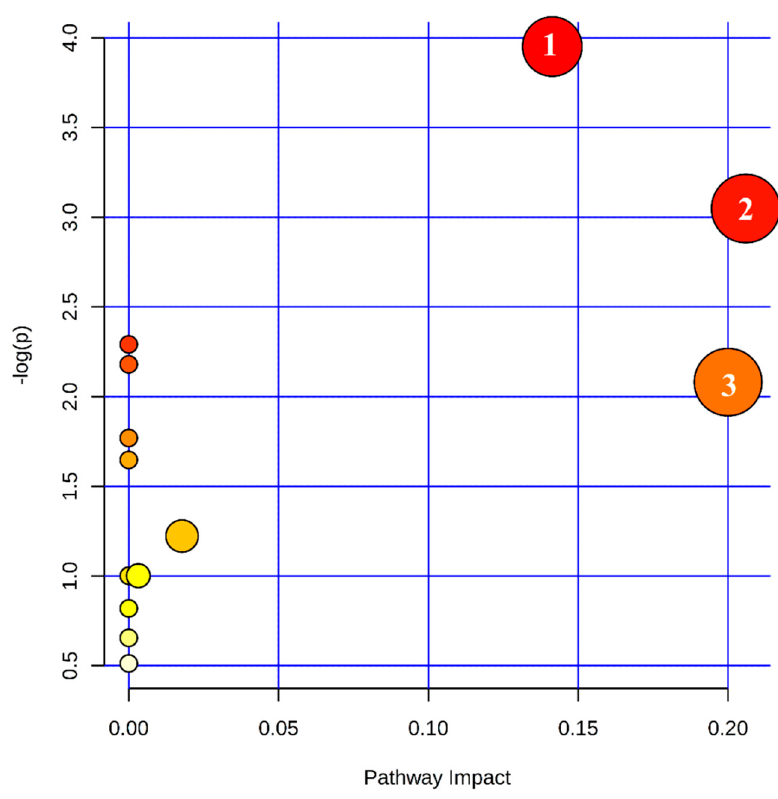
Figure 2. Overview of pathway analysis of white and black sesame. Significantly different metabolites are from three pathways including (1) phenylpropanoid biosynthesis; (2) tryptophan metabolism; (3) riboflavin metabolism.